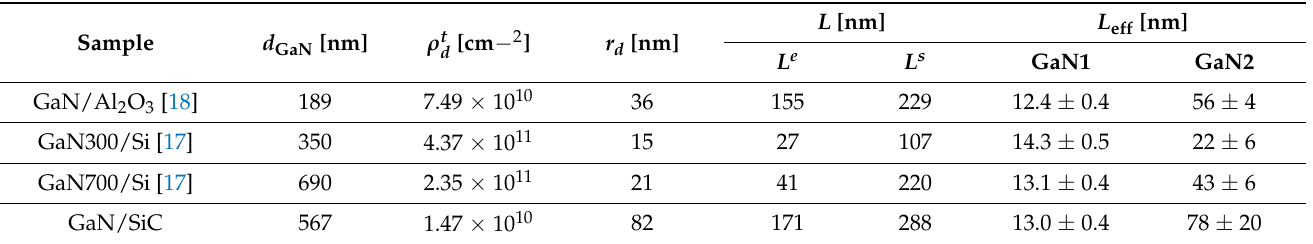
Table 2. Total defect densities, defect correlation lengths, and effective positron diffusion lengths in GaN, where d is the layer thickness, ρ t is the total threading dislocation density, r d is the mean distance between two dislocations, L is the defect d correlation length (edge and screw), and L eff is the effective positron diffusion